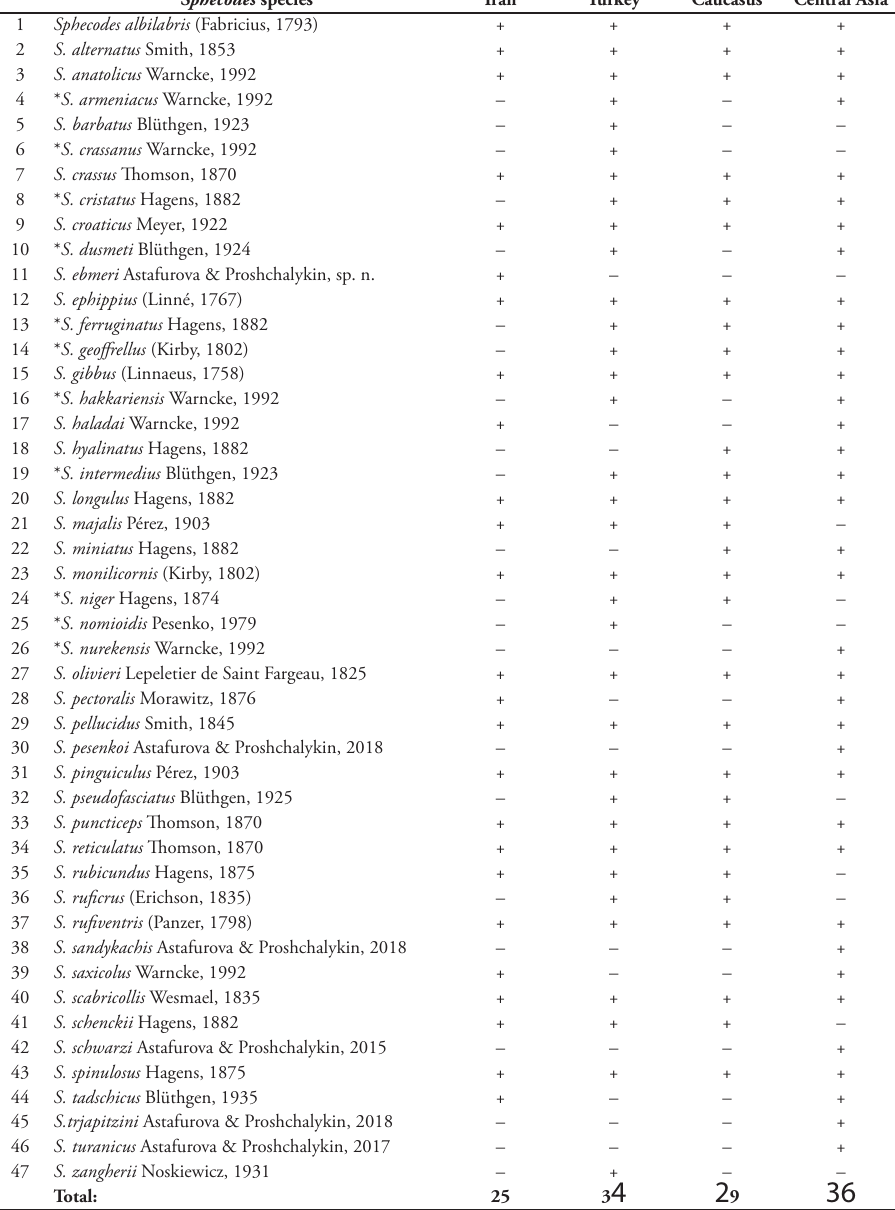
Table 1. List of Sphecodes species recorded in Iran, Turkey, Caucasus and Central